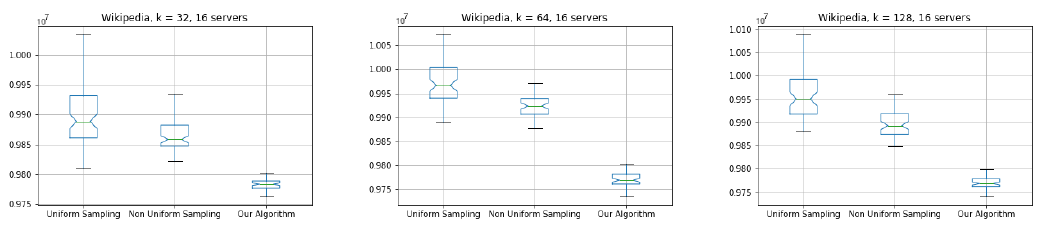
Figure 7. Error (y-axis) box-plots for wikipedia dataset, distributed computation for k = 32, 64 and 128.